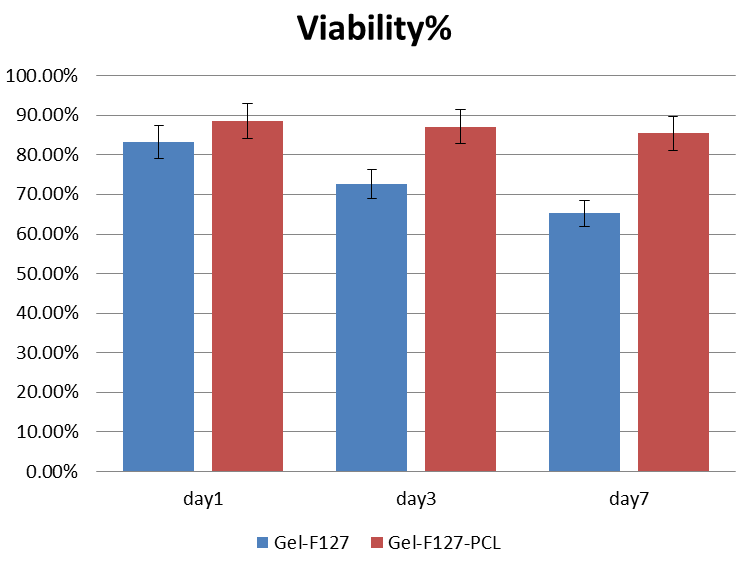
Figure 7. Time course of HUVECs viability after being seeded on group Gel-F127 and group Gel-F127-PCL. Cell viability was analyzed using ImageJ. The error bars indicate standard deviations.